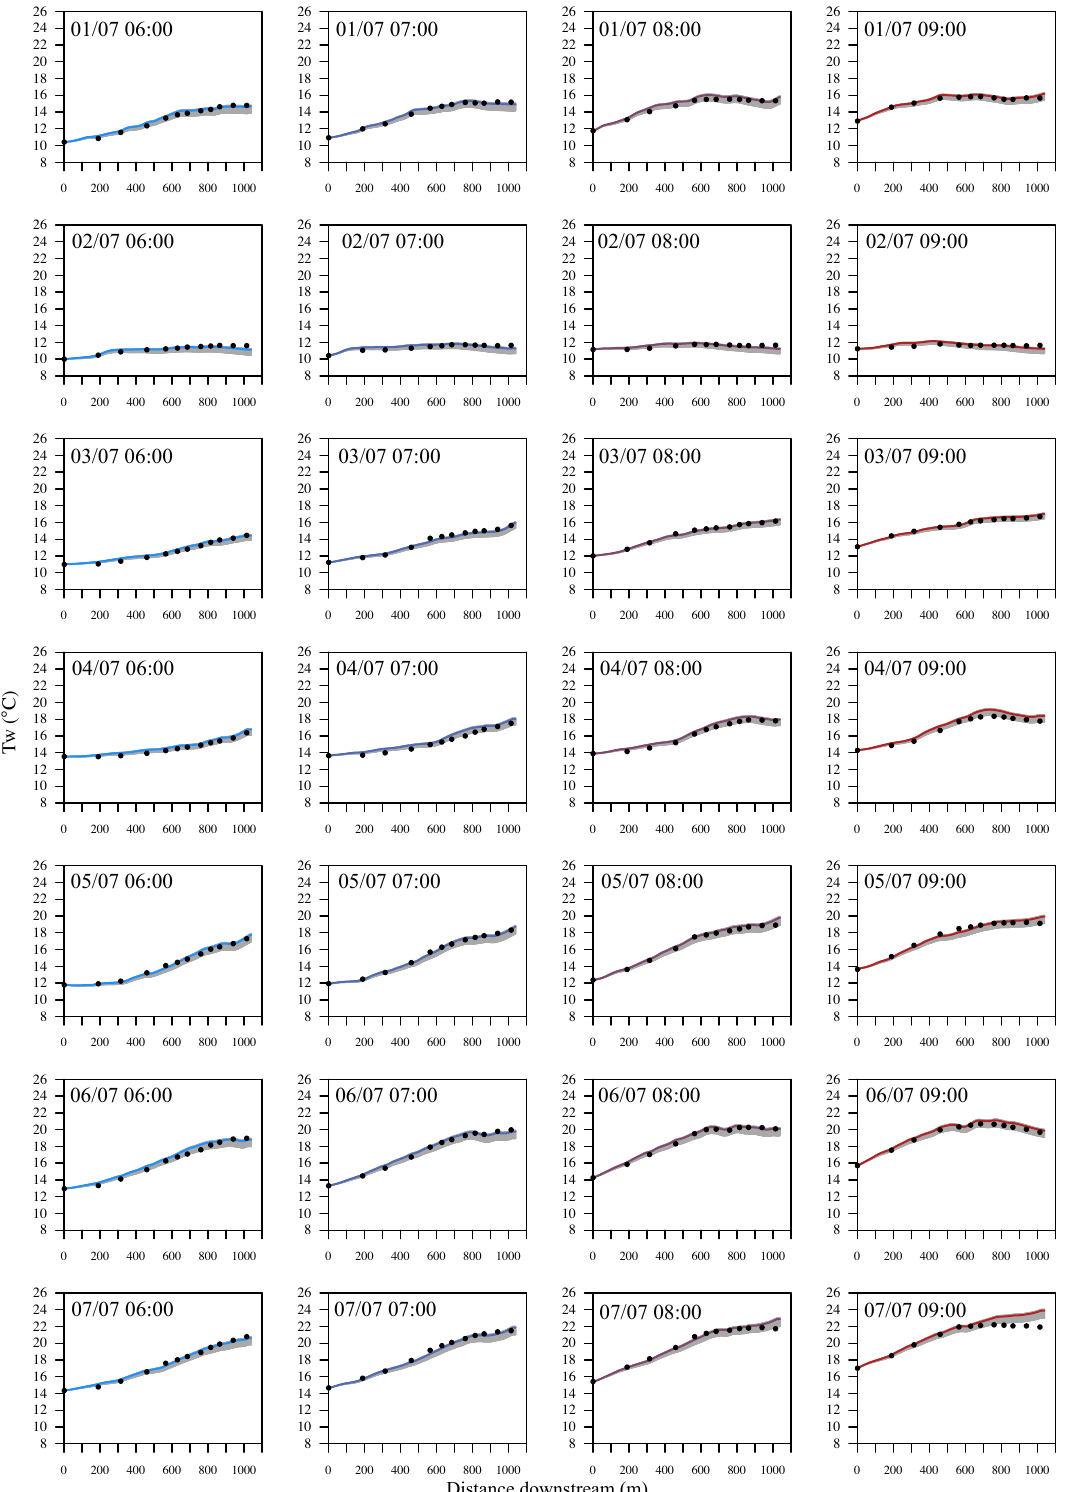
Figure 8. Modelled (lines) and observed (points) water temperatures of parcels released from AWS Open at hourly intervals between 06:00 and 09:00GMT on each day of the study period. Grey envelopes demonstrate the influence of the threshold parameter used to convert hemispher- ical photographs to binary images prior to incident solar-radiation modelling. Lower bound is representative of the maximum threshold value; upper bound is representative of the minimum threshold